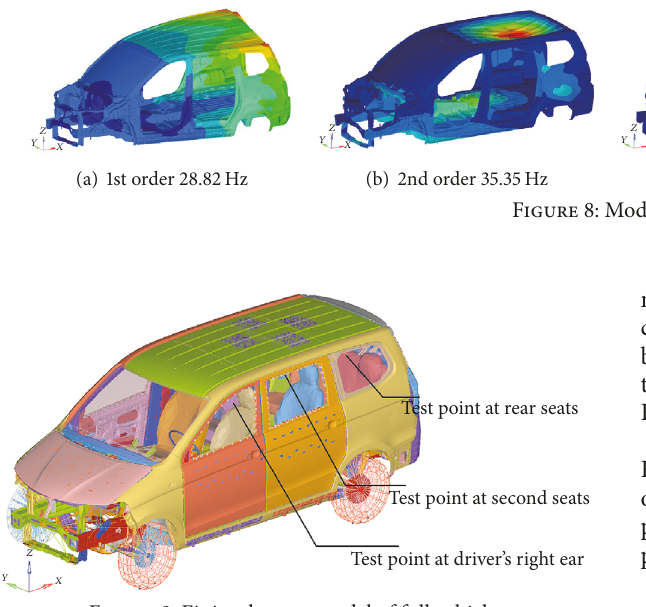
Figure 9: Finite element model of full